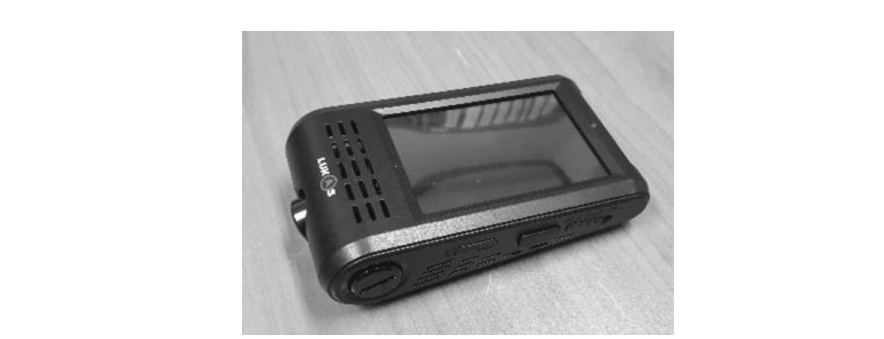
Figure 10. Monocular camera. Table 4. Monocular camera